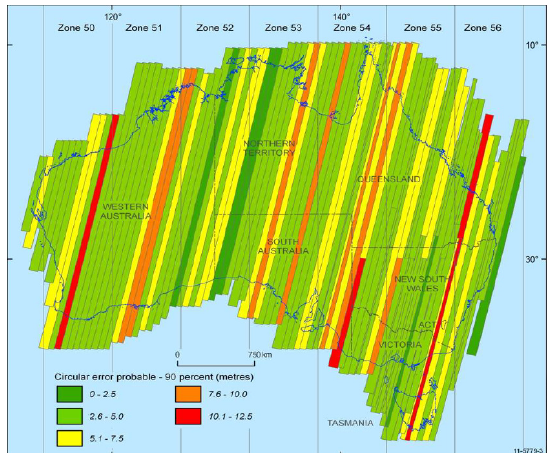
Figure 2. 206 PRISM image strips used to compile AGRI, along with estimates of strip georeferencing